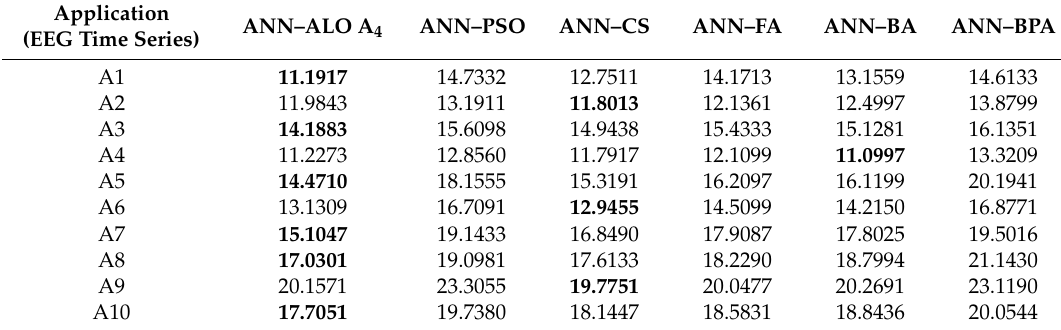
Table 7. Mean MAE values of predictions done for the EEG time series via different ANN-based systems.